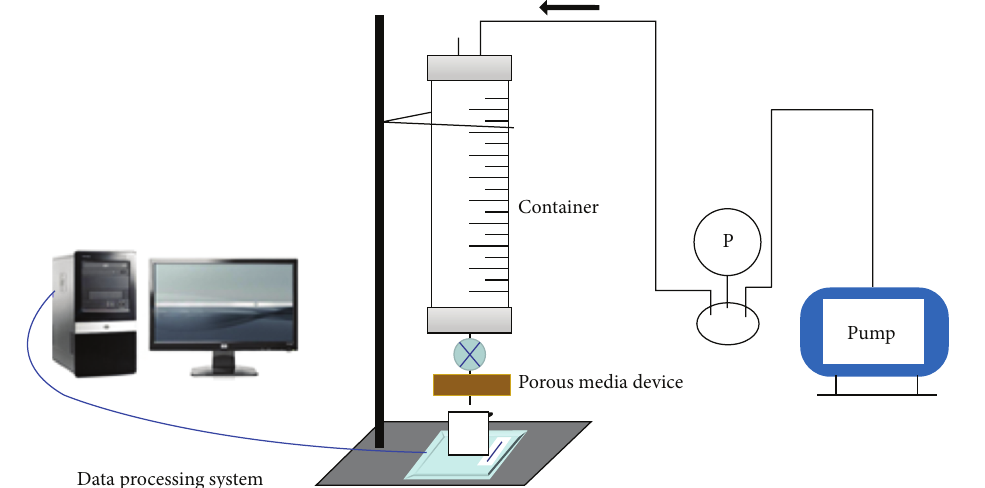
Figure 1: Device for hydrodynamic feature size testing.